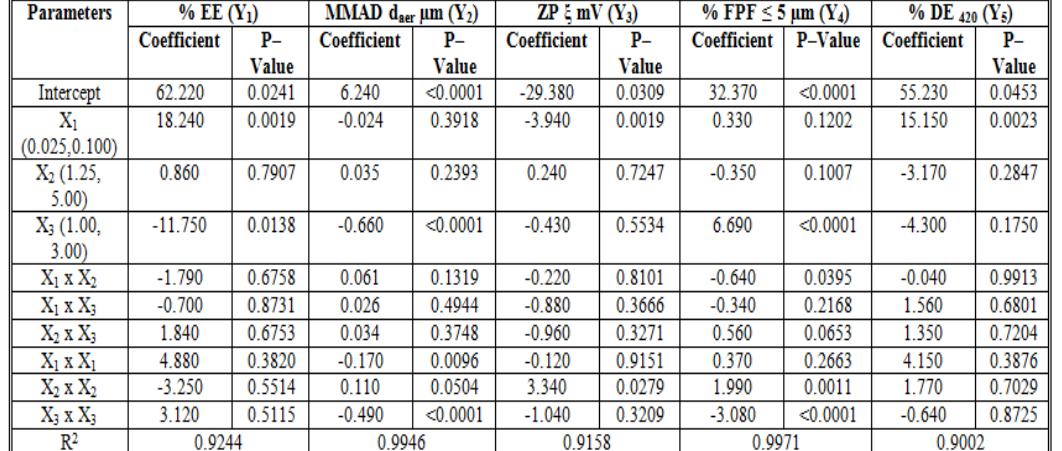
Table 7: Analysis of variance (ANOVA)